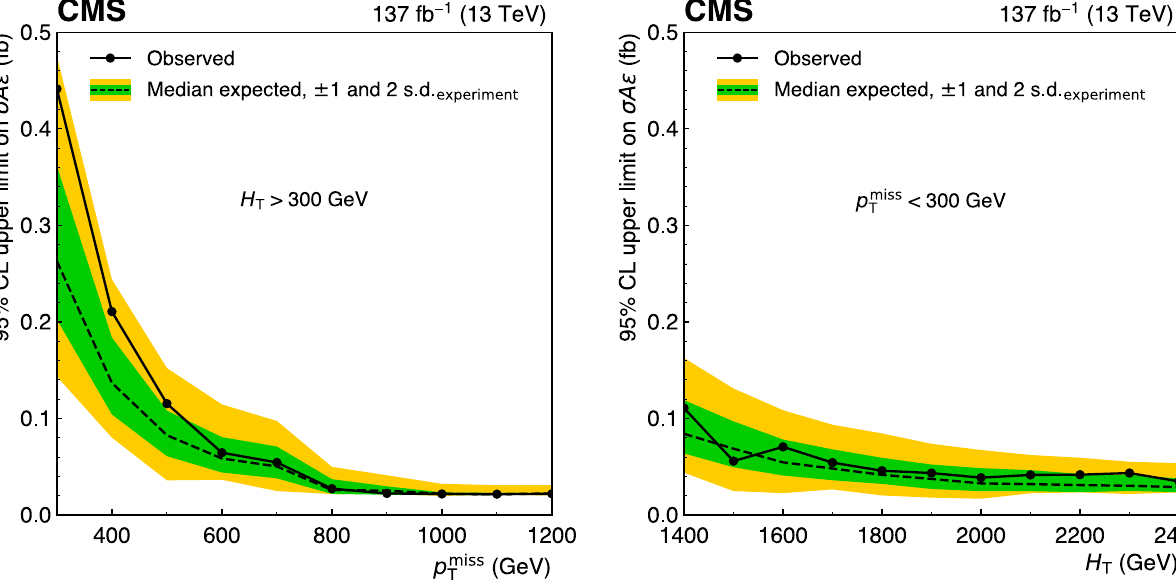
threshold, when H T > 300GeV (left), or the minimum H T threshold, when T